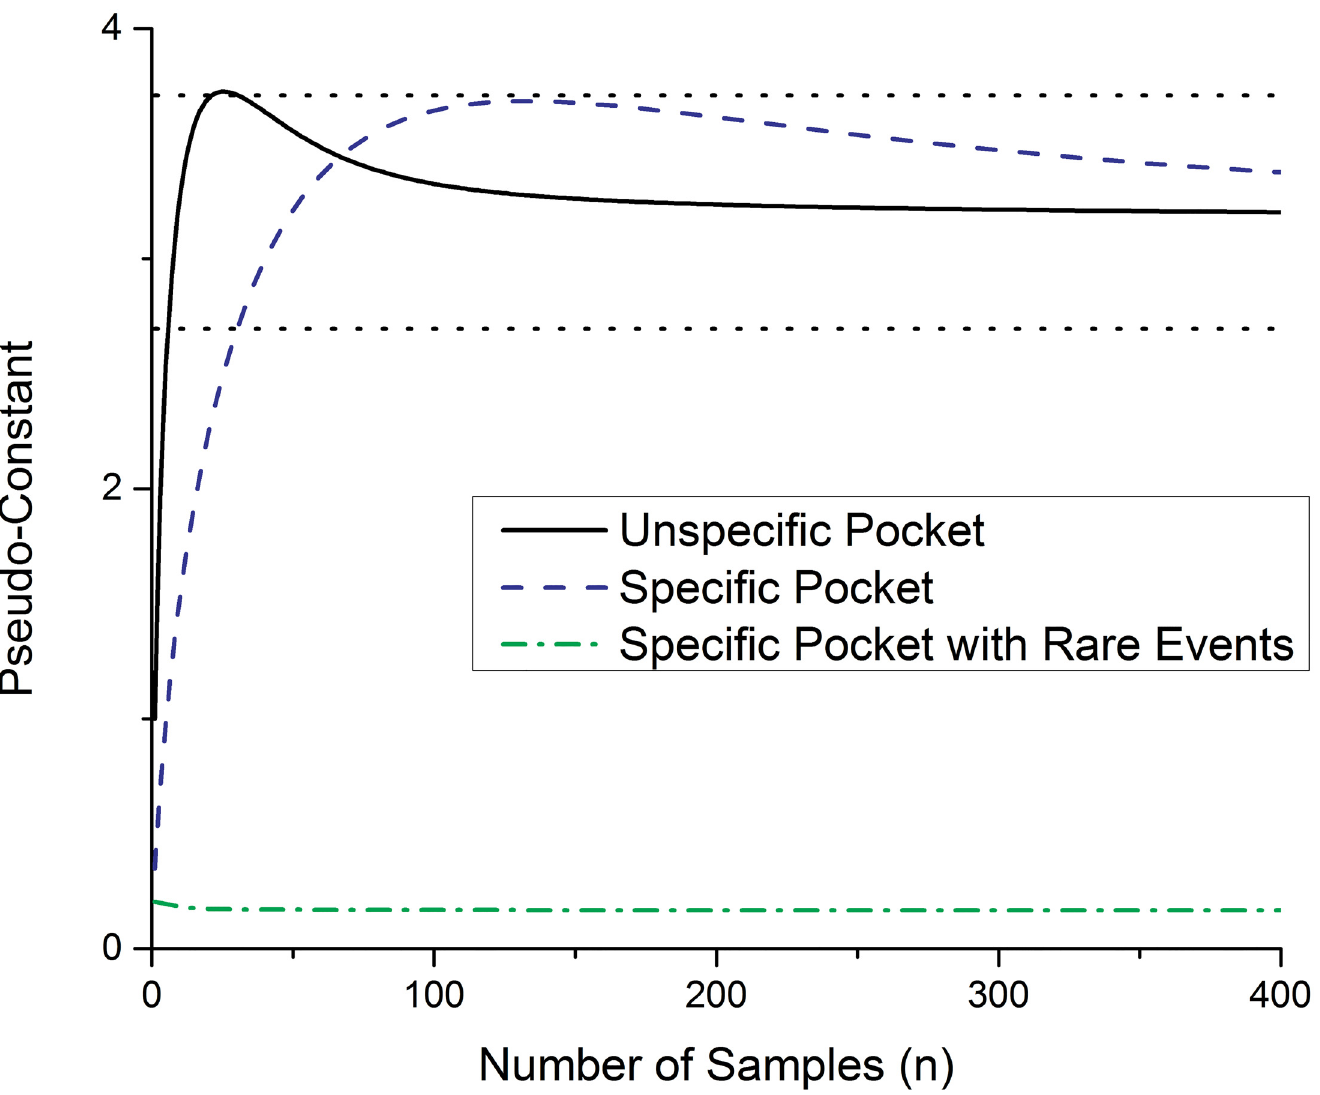
Fig 1. Dependence of the Pseudo-constant C with the number of samples n. The black full line indicates the value for an unspecific pocket, the black dotted lines indicate the region where the value of the Pseudo-constant is less than 15% off compared to the infinite number value. The green dashed dotted line shows the behavior of the constant for a specific pocket and the blue dashed line of a specific pocket with rare events (p < 1%).